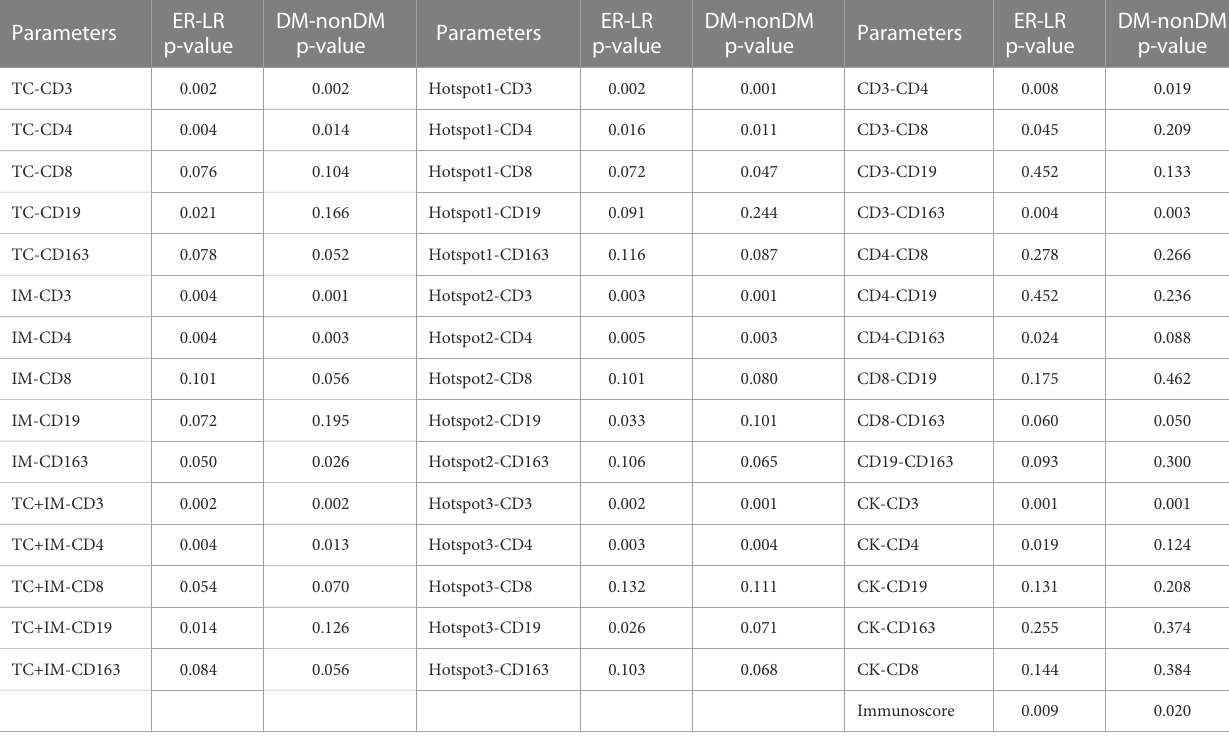
TABLE 2 The comparison of each calculated parameters (positive cell density) between the ER-LR groups and DM-non-DM groups.